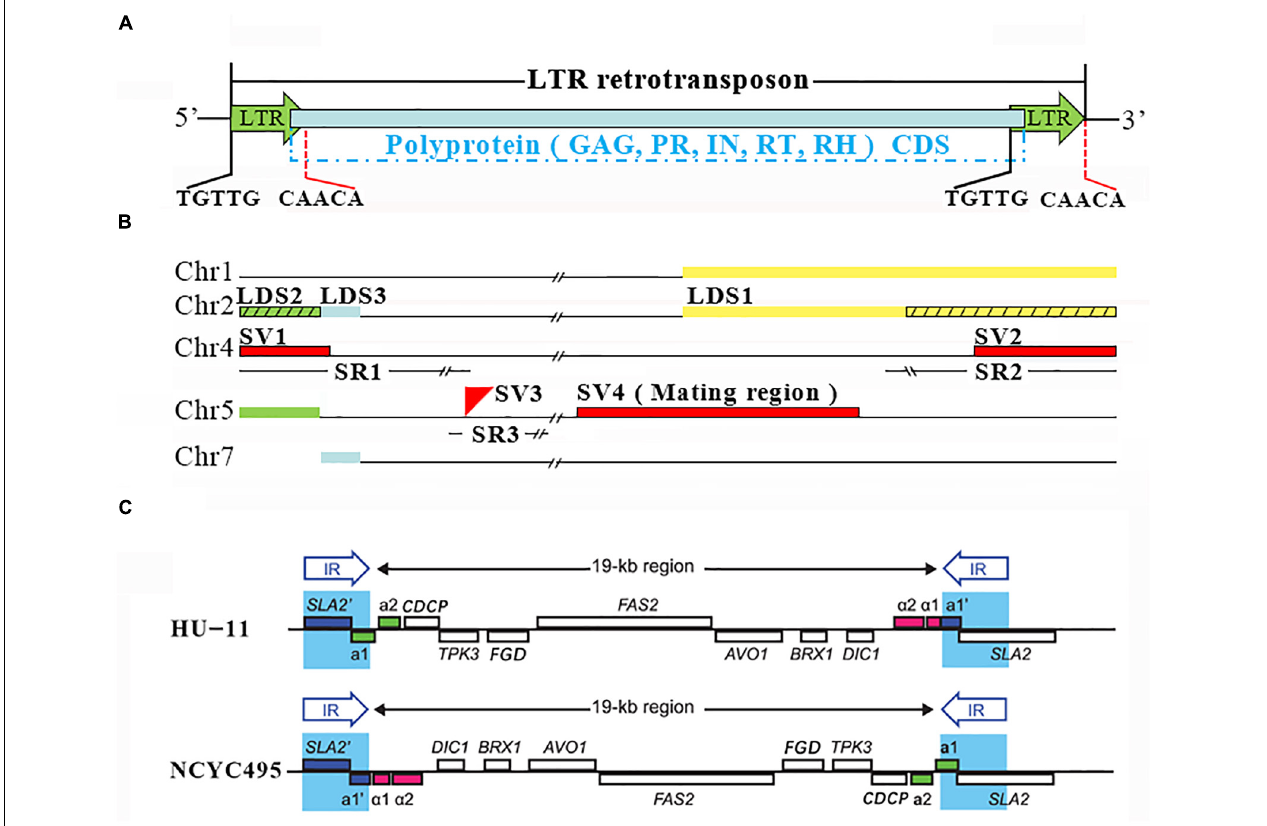
FIGURE 4 | Long terminal repeat (LTR) retrotransposons, large duplicated segments and structural variations. (A) NCYC495 and HU-11/CBS4732 share identical 322-bp LTRs, which are flanked by TCTTG and CAACA at their 5 (cid:48) and 3 (cid:48) ends. Three of seven LTR-rts of HU-11/CBS4732 have no homologs in the NCYC495 genome due to misassembly. A LTR-rt consists of 5 (cid:48) LTR, 3 (cid:48) LTR and a single open reading frame (ORF) encoding a putative polyprotein. This polyprotein, if translated, can be processed into trunculated gag (GAG), protease (PR), integrase (IN), reverse transcriptase (RT) and RNase H (RH). (B) Chr1, 2, 4, 5, and 7 represent the chromosomes (GenBank: CP073033, 34, 36, 37, and 39) of the HU-11/CBS4732 genome. Three large duplicated segments (LDSs) named LDS1 (in yellow color), 2 (in green color) and 3 (in blue color) are supposed to be included in both NCYC495 and HU-11/CBS4732 genomes. However, LDS2 and a 14,090 bp part of LDS1 (indicated by black slashs) were not assembled into chromosome 2 of the NCYC495 genome. The genomic differences between the HU-11/CBS4732 and NCYC495 only include three structural variations (SVs), named SV1, 2 and 3 (in red color). The three SVs are located in three large syntenic regions (SRs) of HU-11/CBS4732, NCYC495, and DL-1 genomes with very high nt sequence identities, named SR1, 2 and 3. SV4 is a 22.6-Kb DNA region which functions in the determination of the yeast mating-type (MAT). (C) The graphic elements used to represent the genomes and genes were originally used in